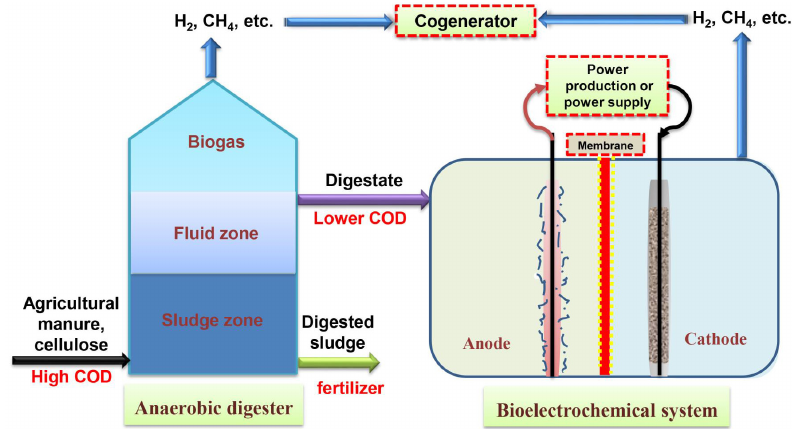
Figure 2. BESs integrated with AD as a post-treatment